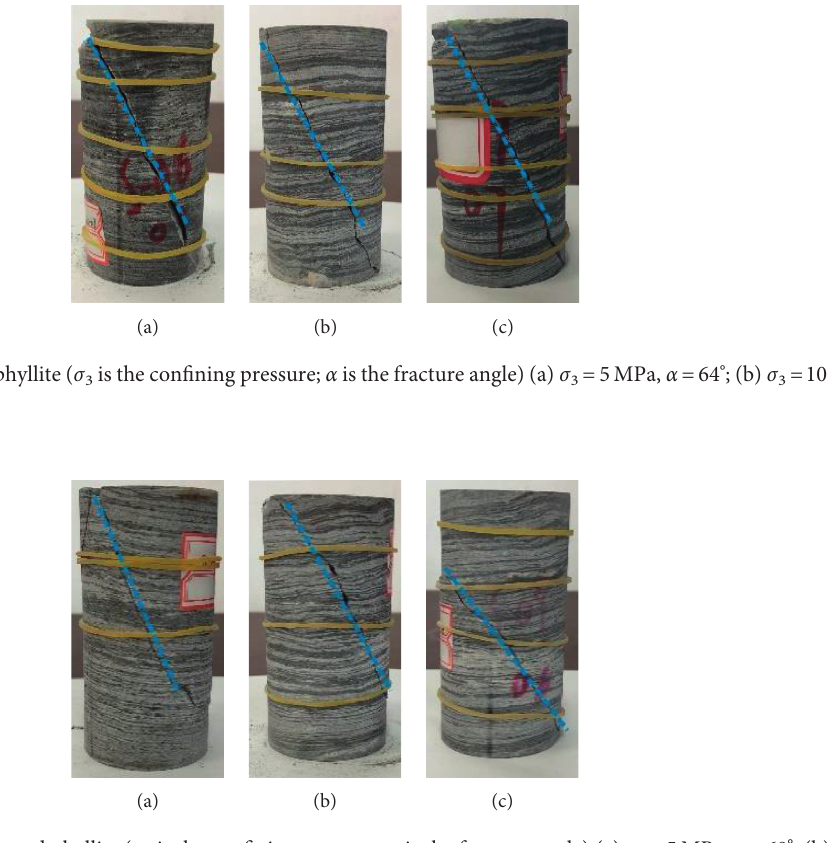
3 is the confining pressure; α is the fracture angle) (a) σ 3